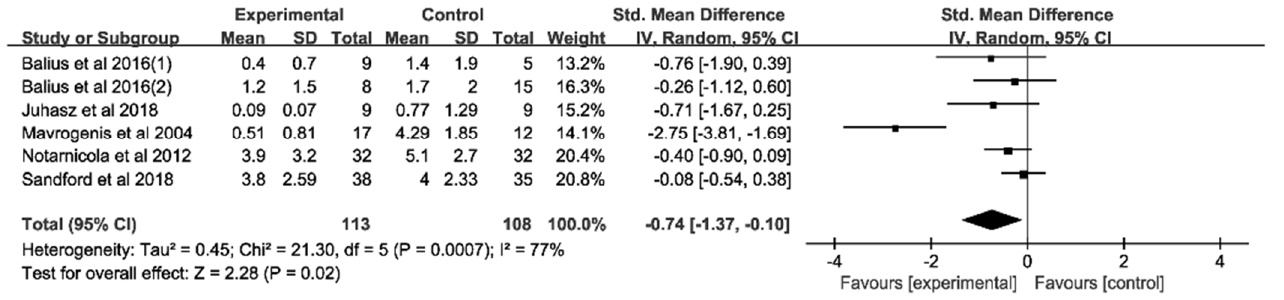
Figure 2. Forest plot of the meta-analysis on pain score at rest. Pain score measurement include NRS and VAS scales. Table 4. Results of subgroup analysis.